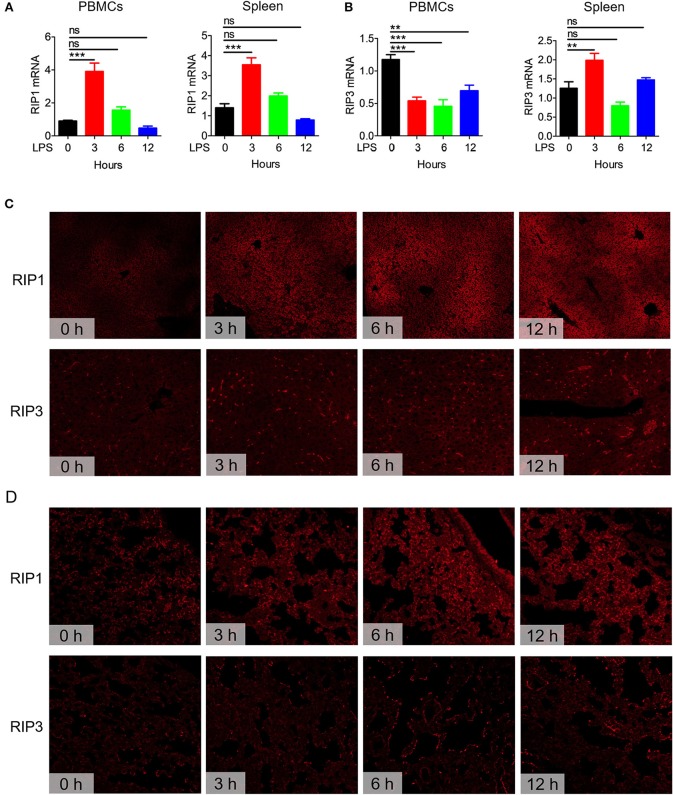
Expression of the necroptosis-related genes RIP1 and RIP3 in mice undergoing endotoxin shock. C57BL/6 mice were challenged with lipopolysaccharide (LPS; 10 μg/g body weight) for 0, 3, 6, or 12 h (n = 8). The expression levels of RIP1 and RIP3 in peripheral blood mononuclear cells (PBMCs) and spleen tissues were examined. (A,B) Q-PCR analysis of RIP1 and RIP3 mRNA transcript expression levels in PBMCs and spleen tissues. Data are presented as means ± S.E.M. of triplicates. (C,D) Immunofluorescence staining to detect RIP1 and RIP3 protein expression in liver and lung tissue sections. Red represents RIP1 or RIP3. Data shown are representative of three independent experiments. Error bars represent S.E.M.; **p < 0.01, ***p < 0.001, as determined by ANOVA test; nsp > 0.05.